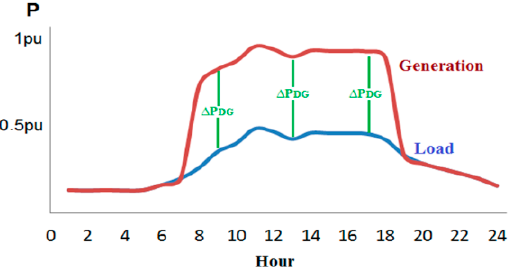
Figure 5. MOR model 2 with one operating interval available to distributor.